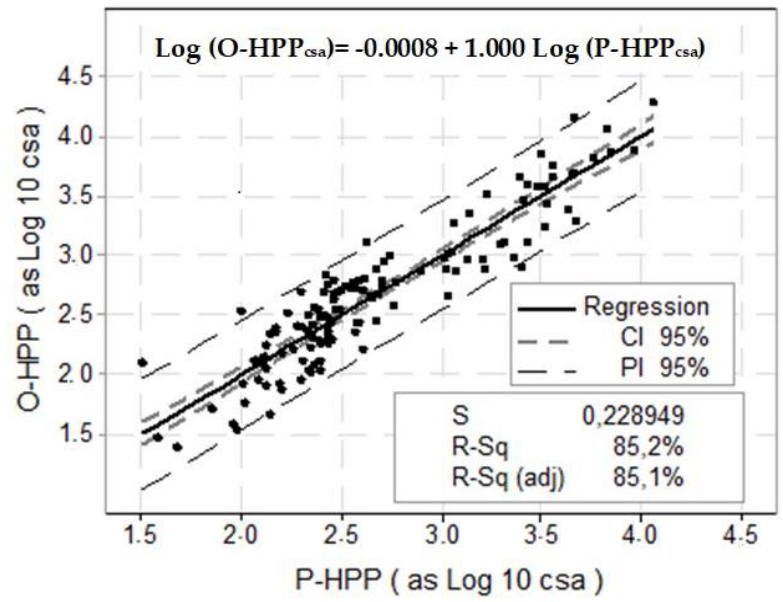
Figure 2. Relationships between the logarithmic-transformed and cell-specific values of the observed (O-HPP) and the predicted (P-HPP) heterotrophic prokaryotic production (L-HPP csa ) obtained from the total dataset regression equation (T DS-RE). The solid line represents the regression line showing the best fit to these data, and the dotted lines represent the 95% confidence intervals (CI) and prediction intervals (PI). The meaning of the statistical parameters is explained in the Ma- terials and Methods section.